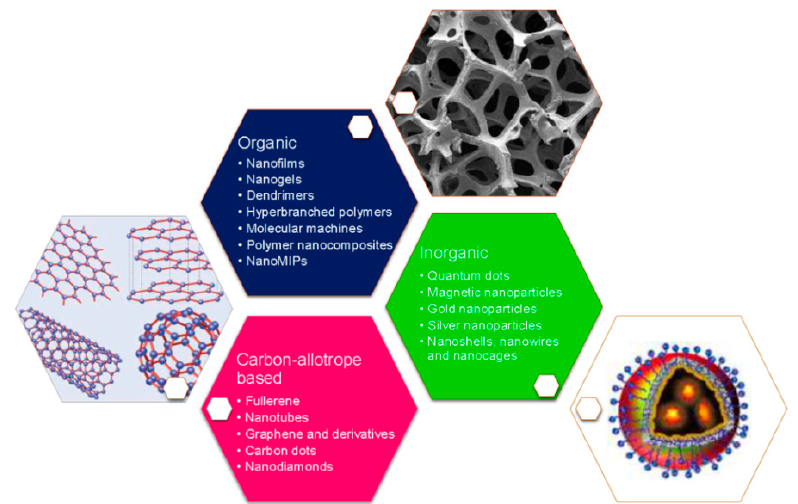
Figure 2. Different nanomaterials and nanostructures used for the development of